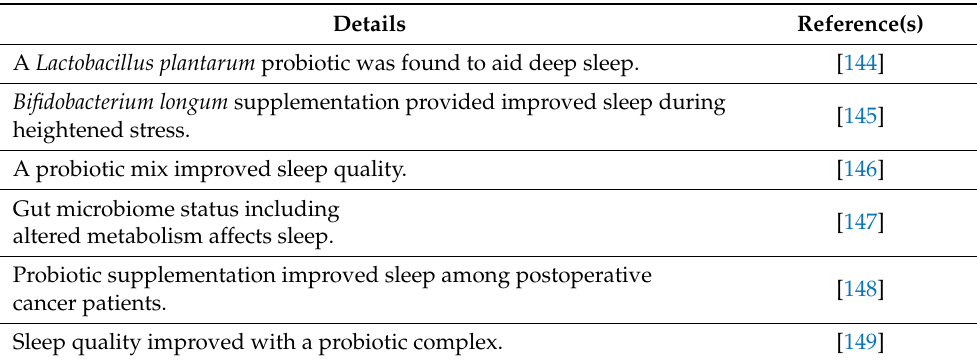
Table 7. Examples of Microbiota Status and Sleep in